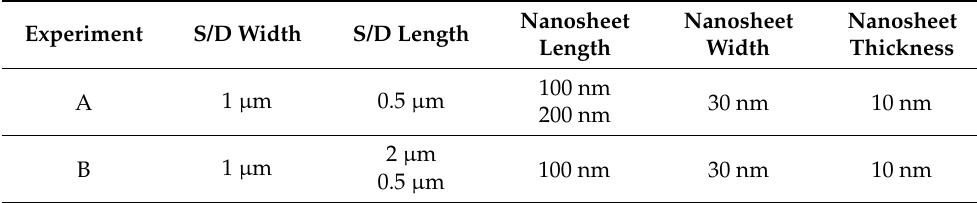
Table 1. Physical parameters of the GAA device in experiment. Experiment